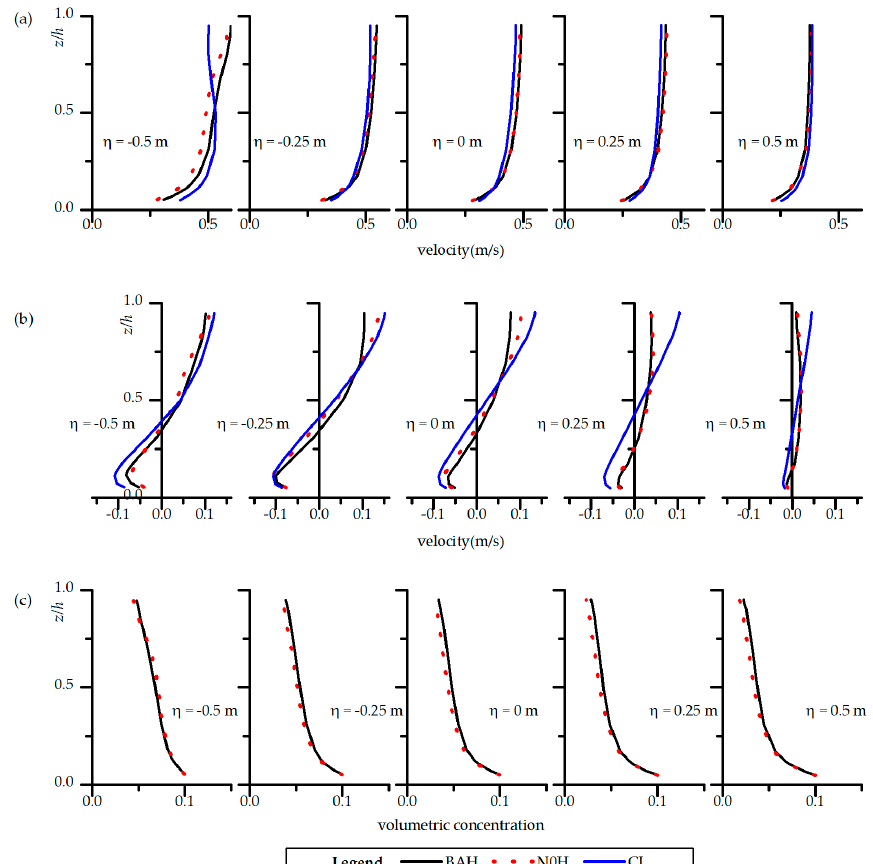
Figure 8. Velocity and sediment concentration profiles at the cross-section 180° for higher concentration case: ( a ) Streamwise velocity; ( b ) transversal velocity; ( c ) sediment volumetric concentration. (velocity unit: m/s).